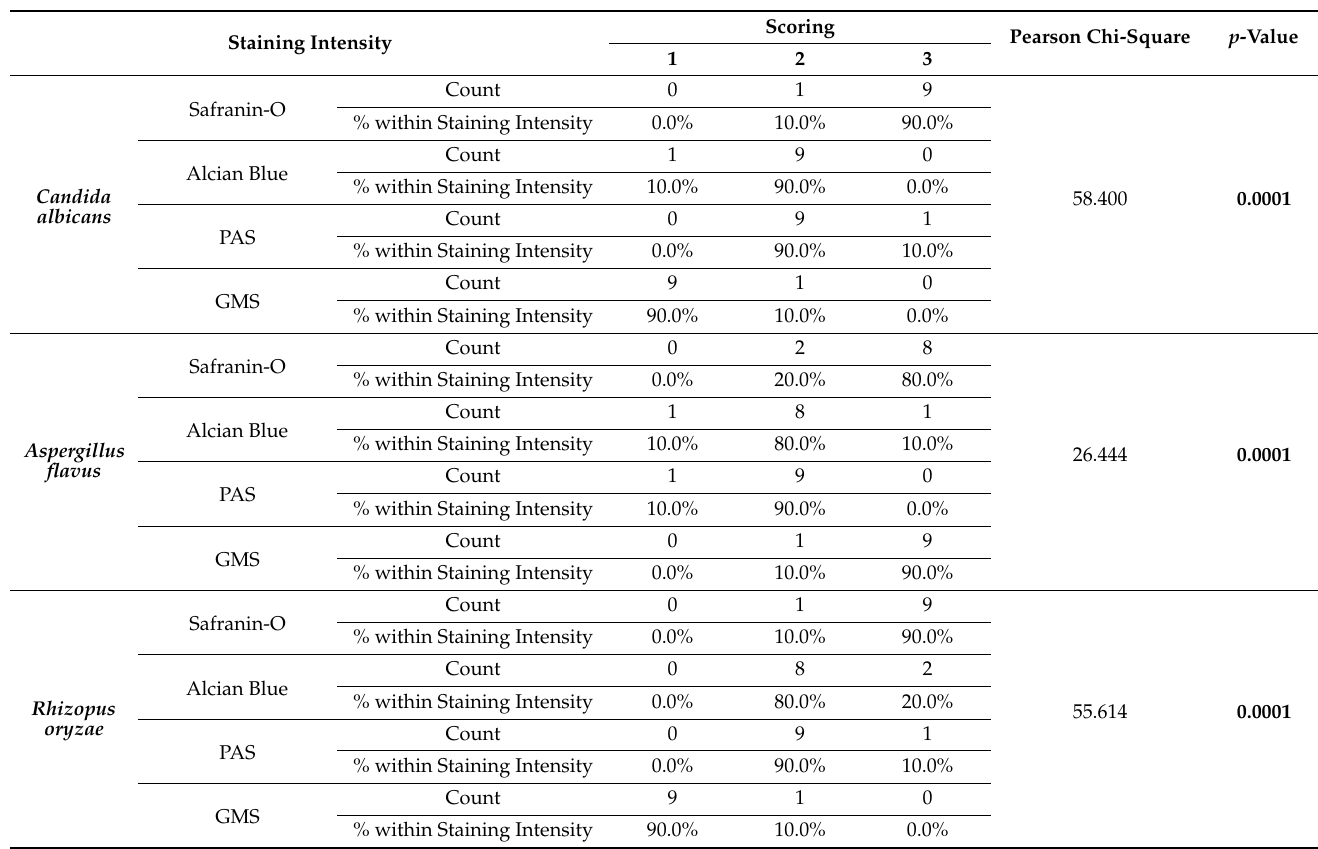
Table 2. Comparison of staining intensity of hyphae of Candida albicans , Aspergillus flavus and Rhizopus oryzae .